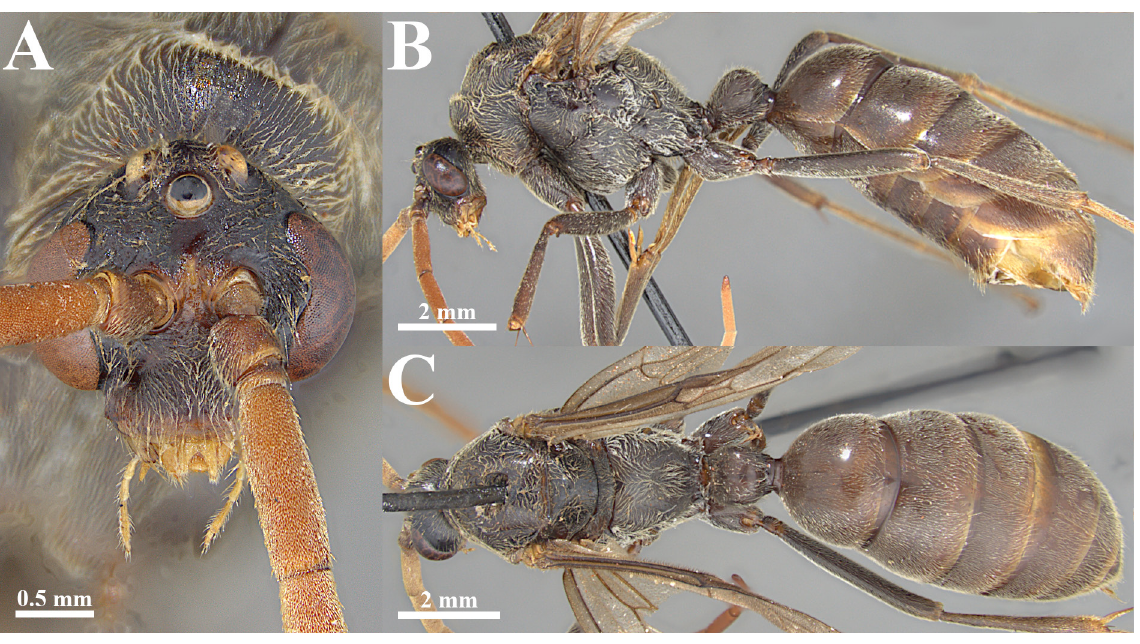
Fig. 18. Dinoponera grandis (Guérin-Méneville, 1838), ♂ (specimen from Itahum, Mato Grosso do Sul, Brazil; MZSP 62284). A . Full-face view. B . Full body in lateral view. C . Full body in dorsal